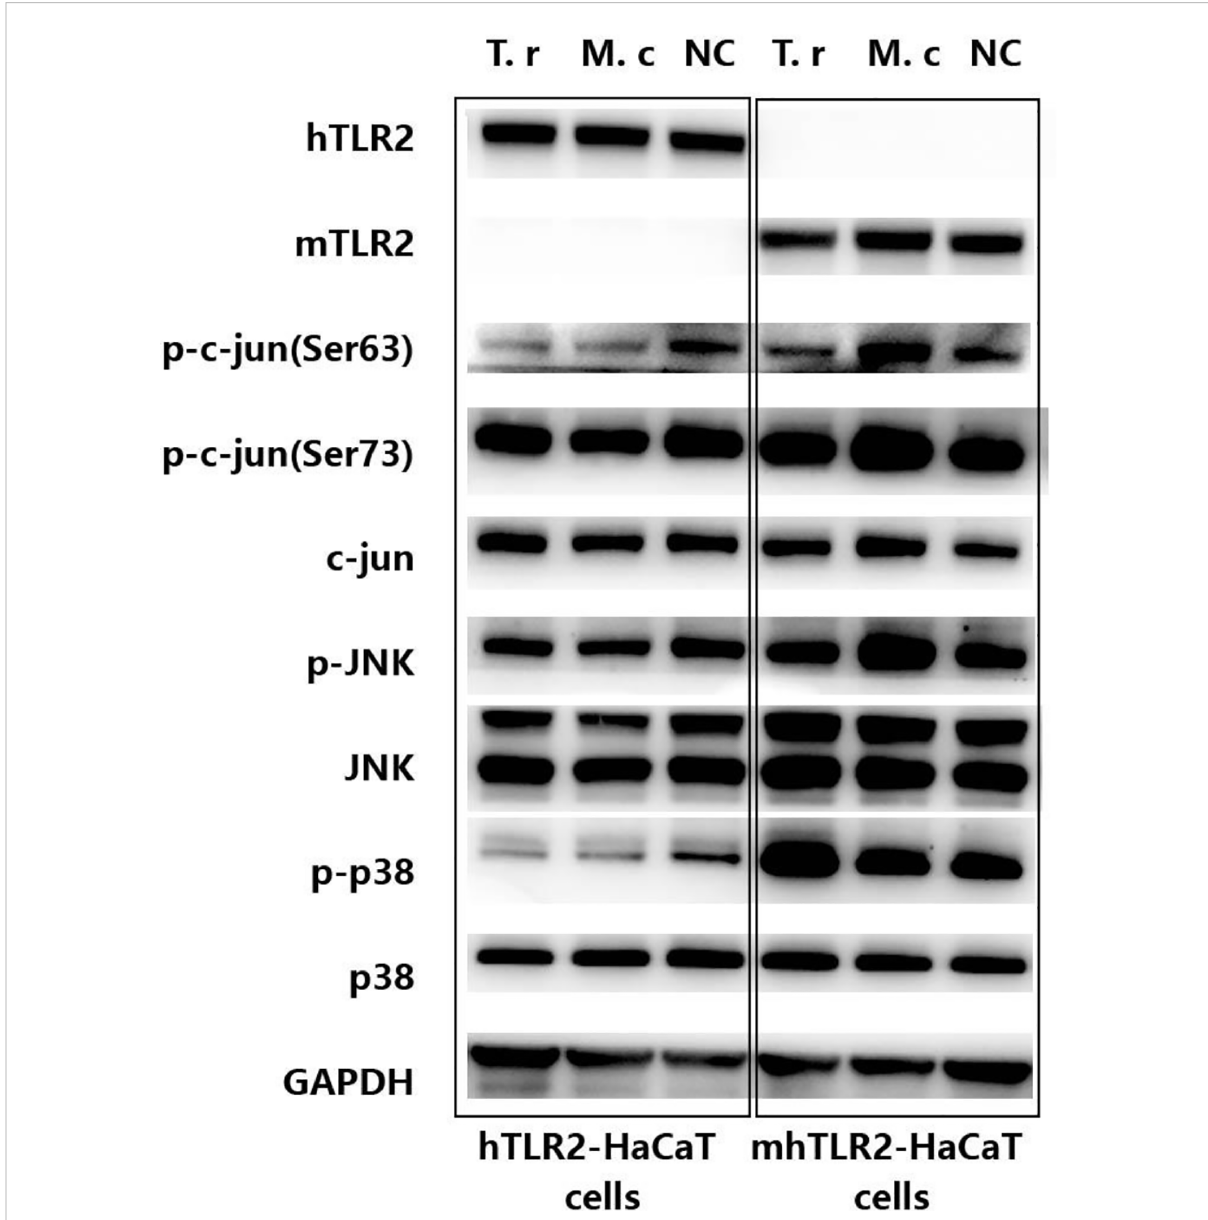
FIGURE 3 Immunoblotting results of proteins from c-Jun and p38 signaling pathway in hTLR2-HaCaT cells, mhTLR2-HaCaT cells co-cultured with T. rubrum and M. canis for 24 h. Representative data came from one of two independent experiments. (T. r represents T. rubrum ; M. c represents M. canis ; NC represents negative